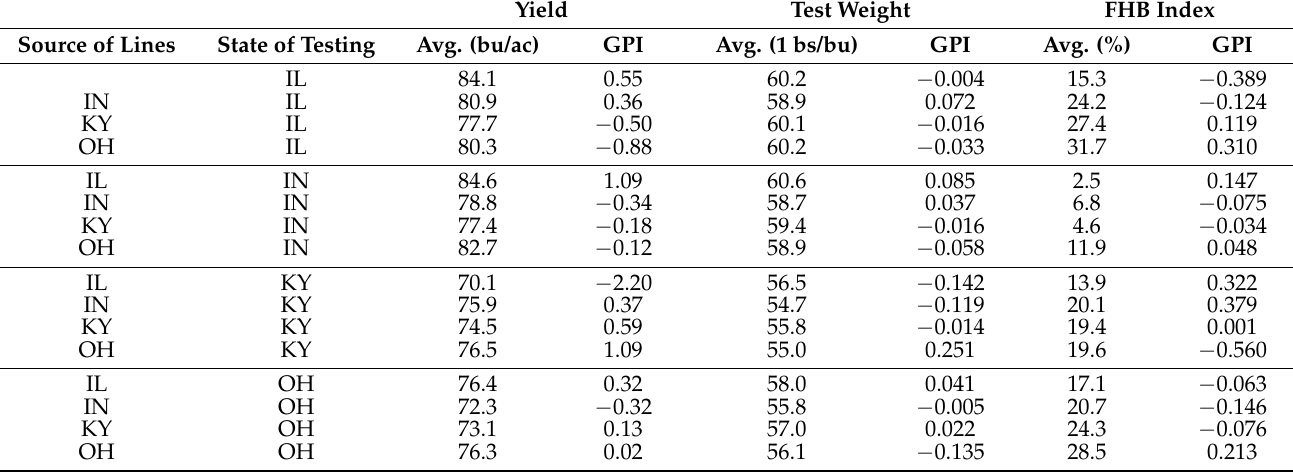
Table 3. Average trait values and genotype by testing program interaction (GPI) of lines evaluated in a cooperative trial conducted by breeding programs located in four states (IL, IN, KY, and OH). The results are parsed by the source of the lines and by where the lines were tested. Yield and test weight values come from analysis of the 5-State trial while the Fusarium Head Blight (FHB) values from analysis of the P+NUWWSN trials.